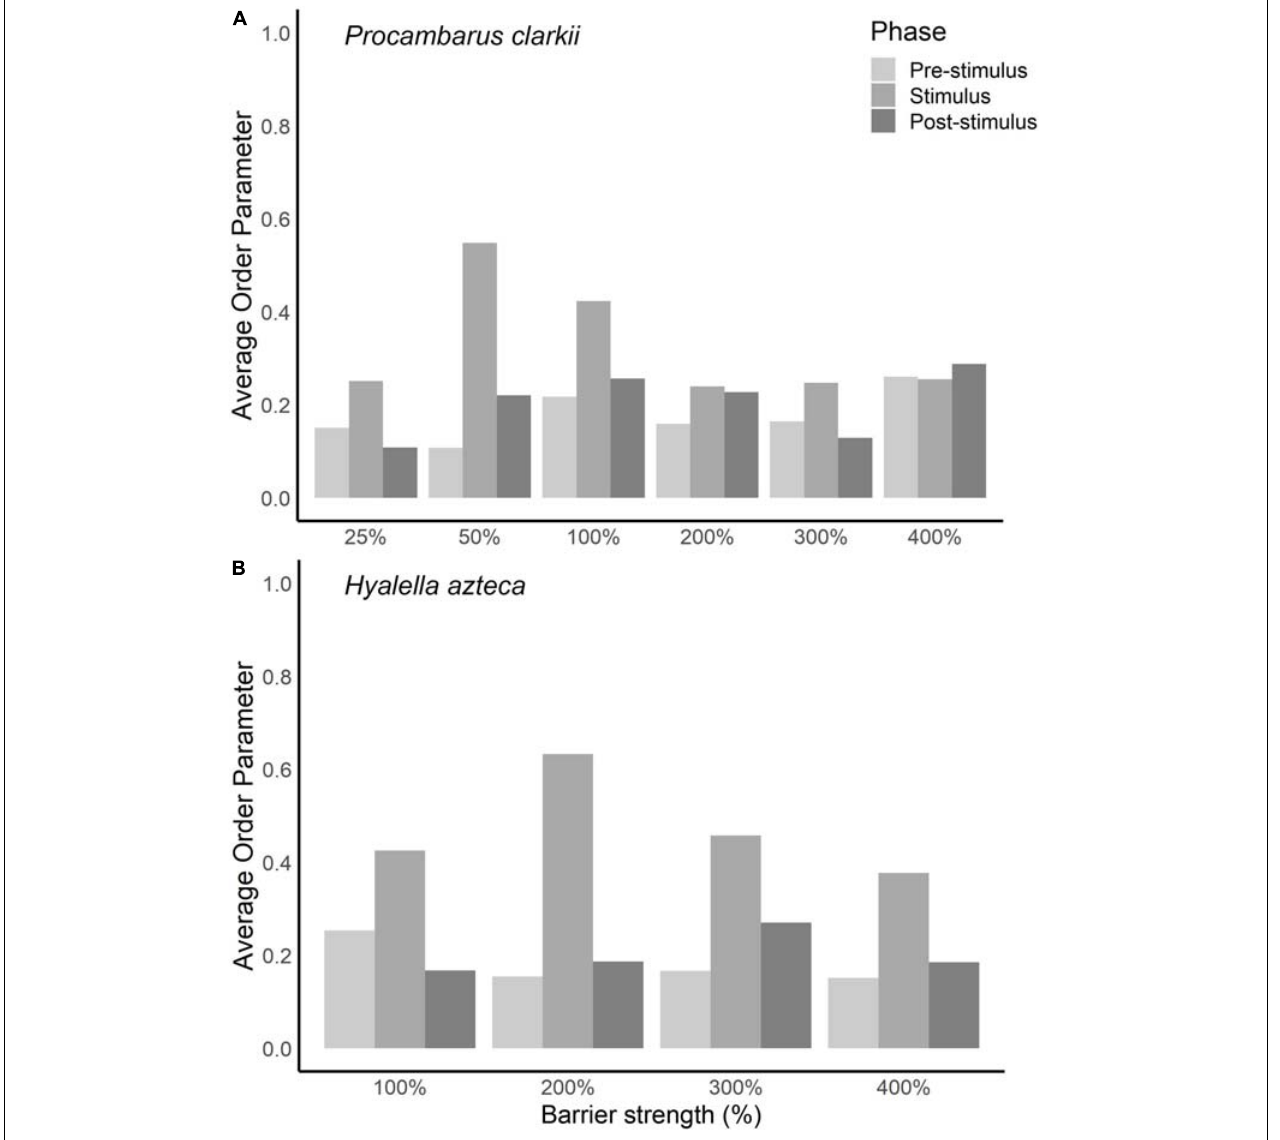
FIGURE 3 | Average order parameter values while barrier was turned off (pre- and post-stimulus phases) and while barrier was turned on (stimulus phase) for different barrier strengths for (A) Procambarus clarkii and (B) Hyalella azteca